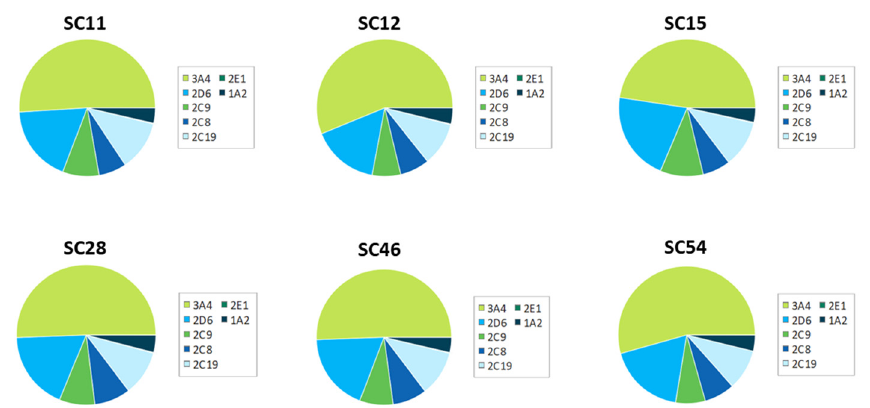
Figure 4. Prediction of the major metabolizing CYP isoform for the compounds in this study. Prediction was achieved using the StarDrop (version 6.6) P450 module. BMS-626529 was also predicted to be predominantly metabolized via the 3A4 isoform.